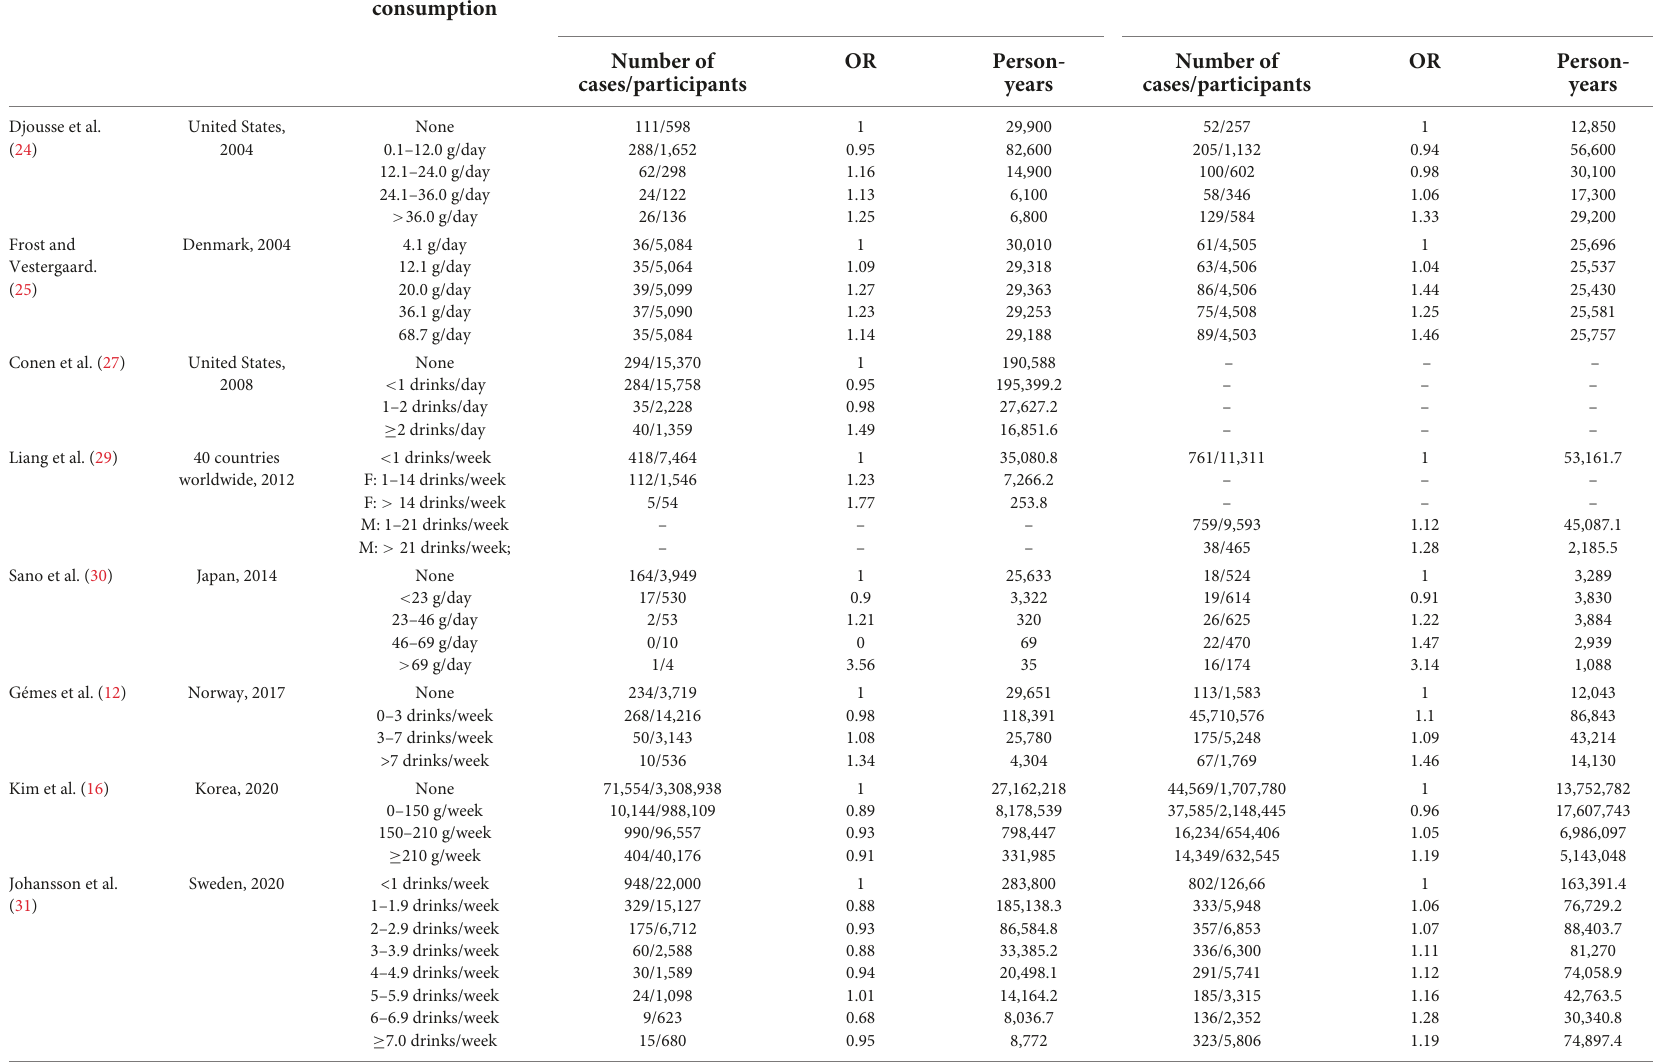
TABLE 2 Total data of studies included in sex-subgroup